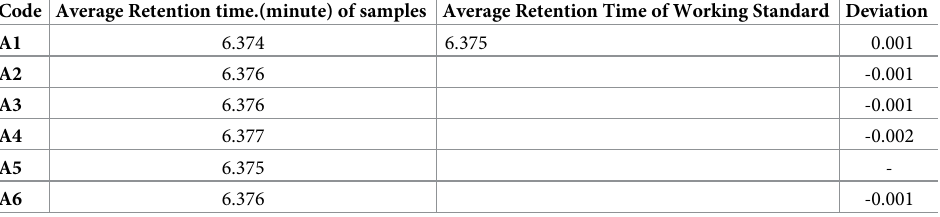
Table 7. Retention time of Azithromycin samples and deviation from the